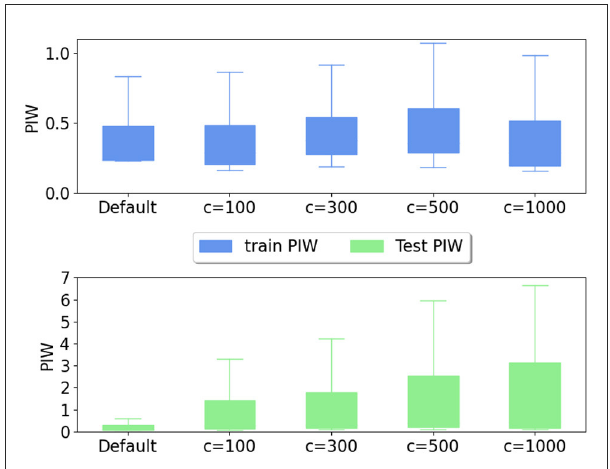
FIGURE7 PIW of the training and test data for different output layer bias initialization in training the two interval networks for the Rock creek catchment. A larger c value initializes the bias to a larger value and the default c value usually draws a sample from a standard Gaussian distribution. Different c values do not affect training and any large c values here can identify the OOD samples with large PIWs, which indicates the reliability of PI3NN.